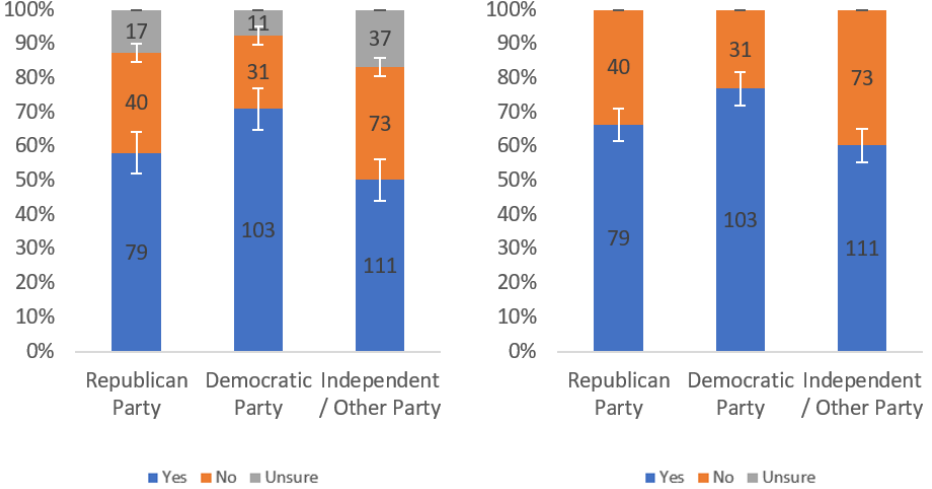
Figure A17. Responses regarding label helpfulness by party affiliation including ( left ) and excluding ( right ) unsure responses.